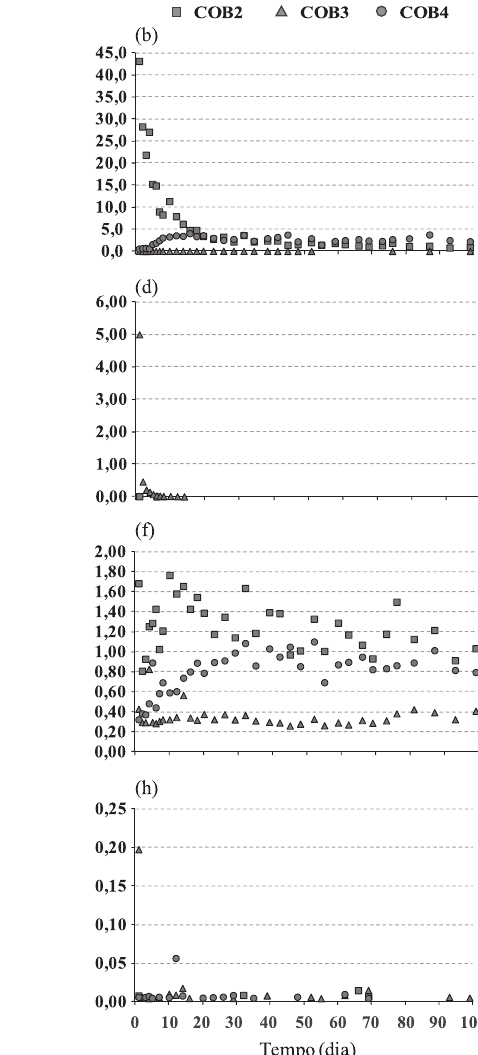
Figura 4. variações de elementos maiores (Al, mn, si e Zn) nas águas lixiviadas ao longo do